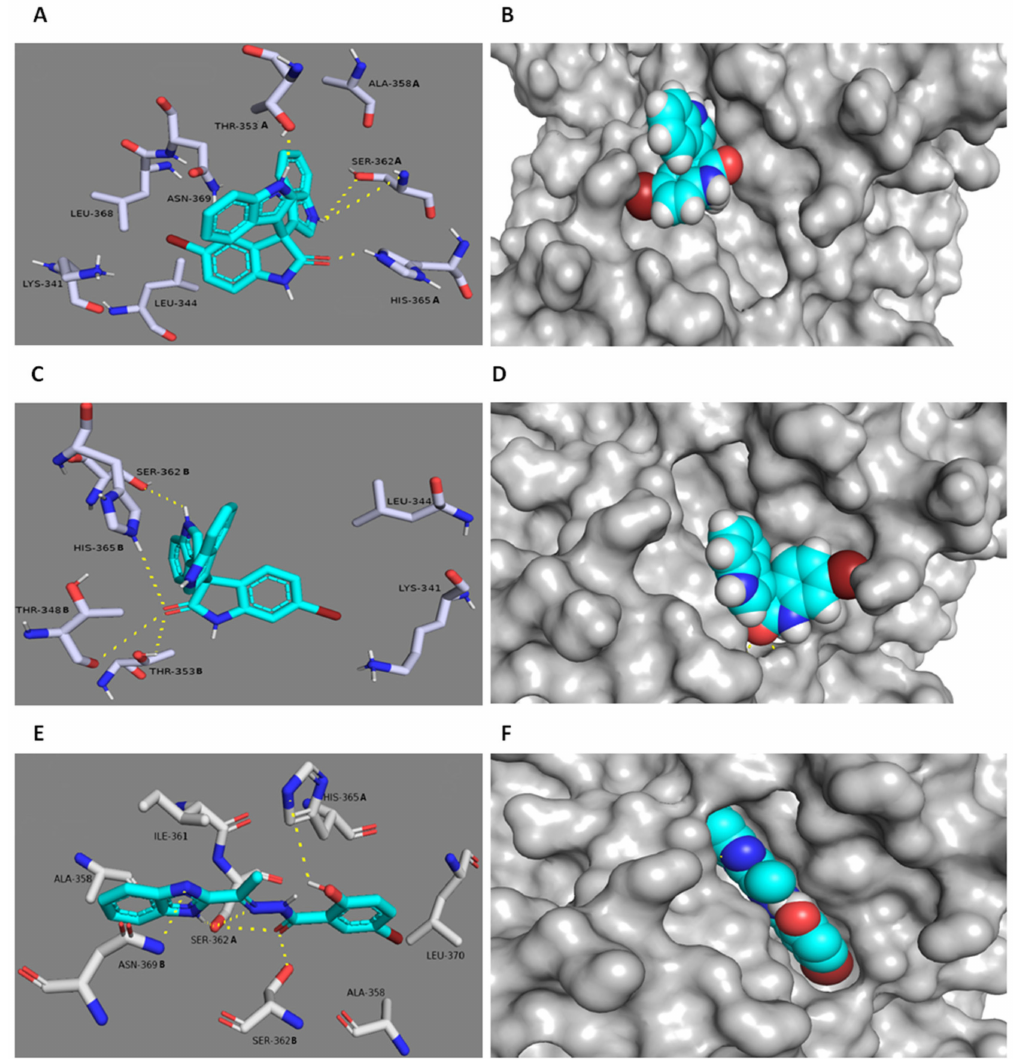
Figure 6. Docking study of 5-Tris ( A , B ) and 6-Tris ( C , D ) within the active site of MRSA PK. The key binding interactions of the PK co-crystallized ligand [21] are shown in ( E , F ). The amino acid side chains are depicted in ( A , C , E ) for